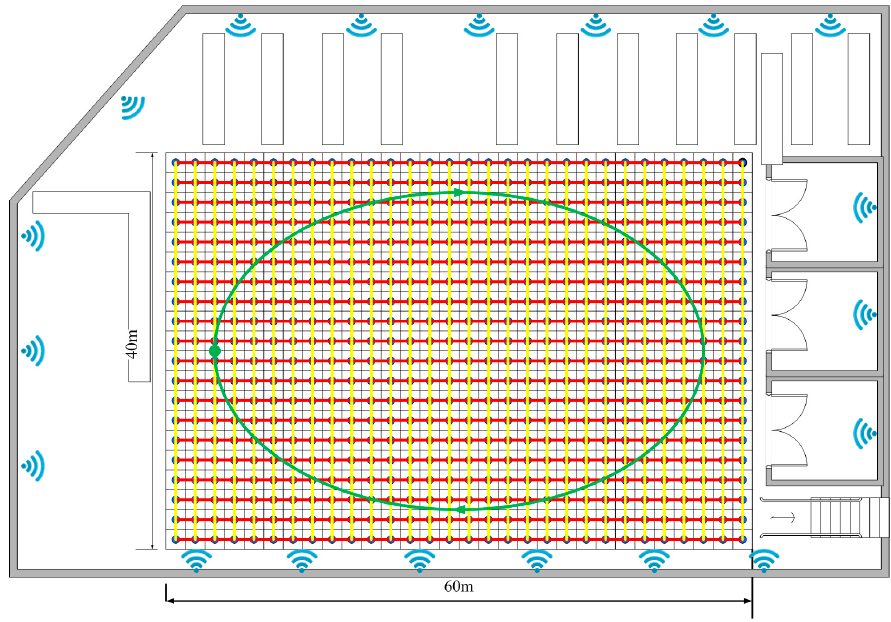
Figure 16. The layout of the first floor of the university library.